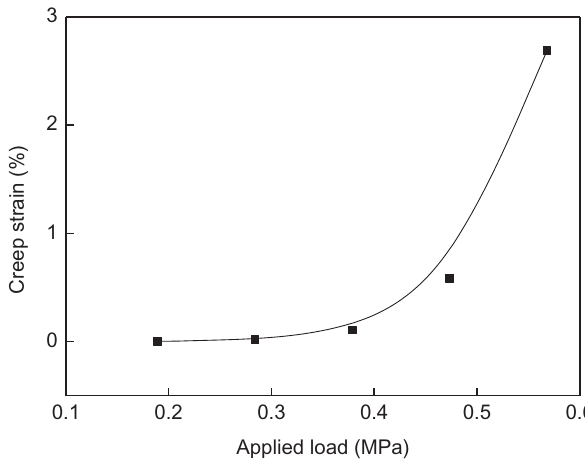
Figure 13: Effect of the applied load on the equivalent creep strain for the whole panel